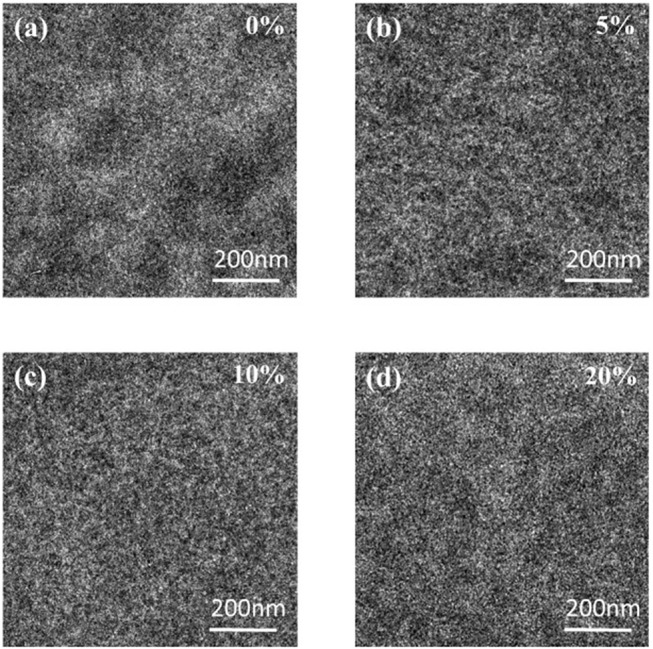
TEM images for (a) PTB7-Th:PC71BM; (b) PTB7-Th: 5%PyPI: PC71BM; (c) PTB7-Th:10%PyPI: PC71BM; (d) PTB7-Th:20%PyPI: PC71BM based film.